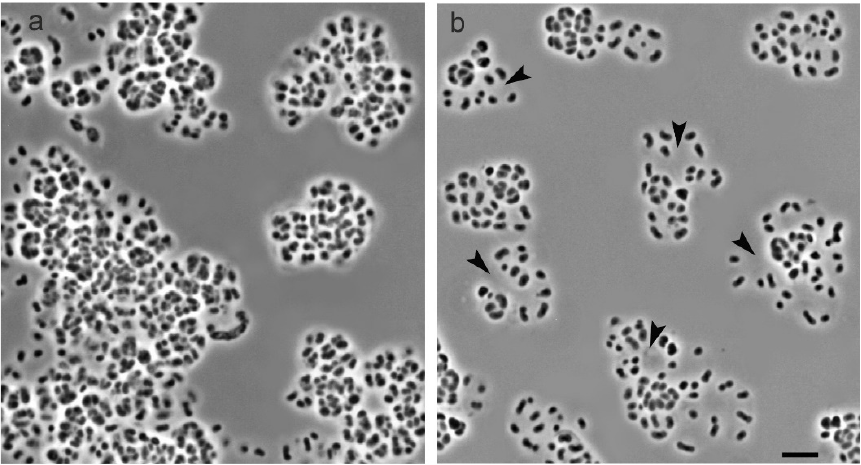
Figure 5. Phase-contrast images of cells aggregates of Acidisarcina polymorpha SBC82 T after cellulase treatment ( b ) compared to intact aggregates ( a ). Clear zones that appeared due to the degradation of cell conglomerates are indicated by black arrows. Bar, 5 μ m.